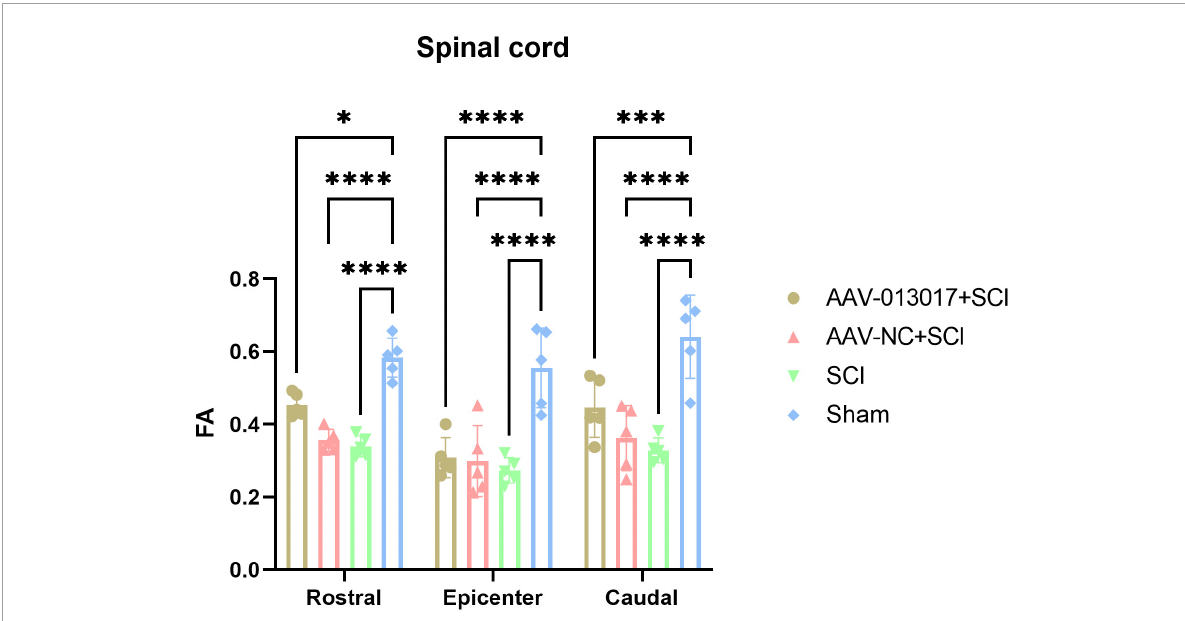
FIGURE5 Diffusion tensor imaging (DTI) detection at 6 weeks after SCI. Fractional anisotropy (FA) was altered in different segments of different groups ( n = 5 per group). ∗ Indicates p < 0.05, ∗∗∗ indicates p < 0.001, ∗∗∗∗ indicates p < 0.0001.